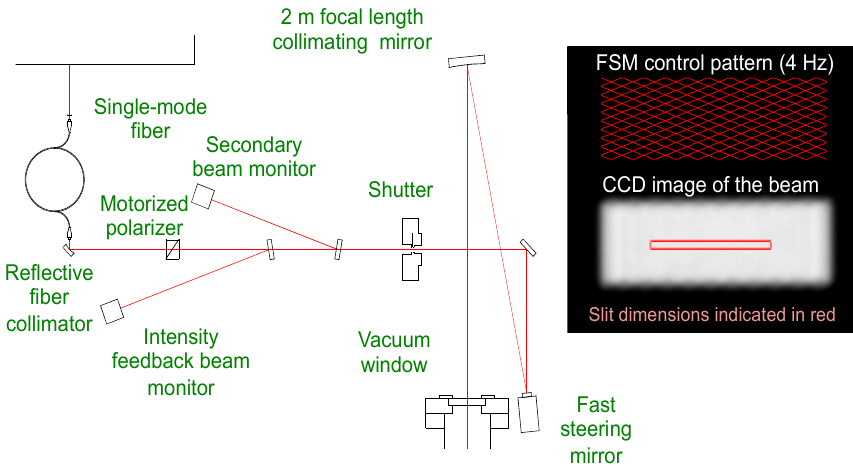
Figure 3. Details of the laser stabilization and beam conditioning optics. A single-mode fiber inputs the selected wavelength to a reflective fiber collimator. Polarization control and intensity stability feedback are accomplished prior to a fast steering mirror. For irradiance mode calibrations, the laser pattern is scanned by the fast steering mirror to generate a uniform intensity field that overfills the critical aperture (either the cryogenic radiometer or SIM entrance slit).